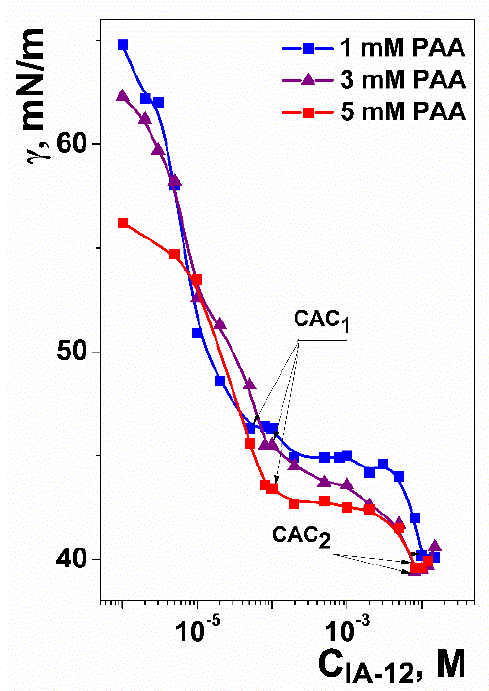
Figure 2. Surface tension isotherms for the IA-12/PAA binary systems at three fixed PAA concentrations; pH = 4, 25 °С. Table 1. Aggregation thresholds of the IA-12/PAA binary systems obtained by different physico- chemical techniques.